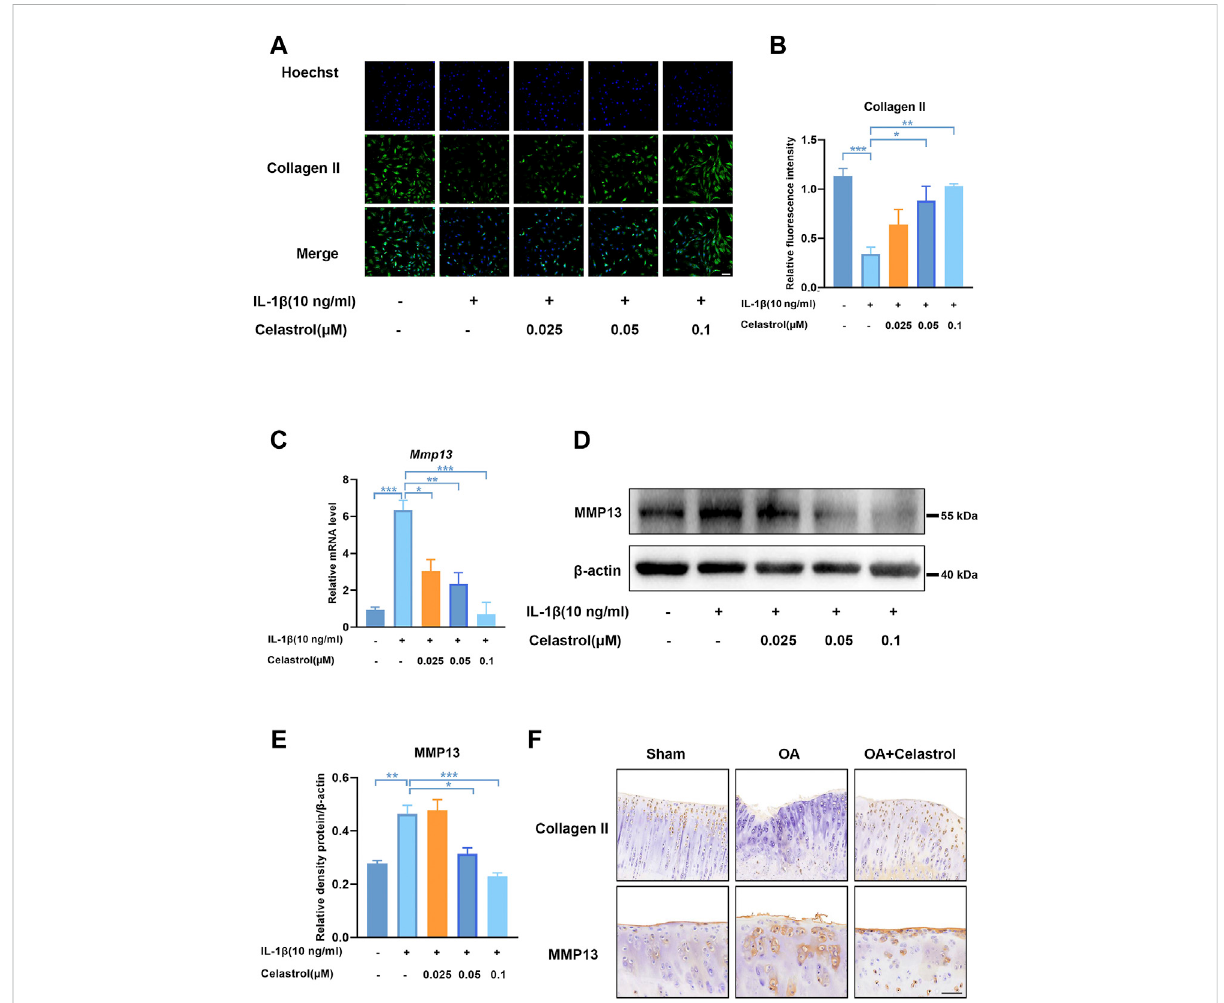
FIGURE 4 Celastrol inhibitedmatrix degradation inrat chondrocytes. (A) Representative immuno fl uorescence staining for Collagen Ⅱ inrat chondrocytes (green: Collagen Ⅱ , blue: DAPI, scale bar:100 μ m). (B) Quanti fi cation of the immunohistochemical staining data from A. (C) The mRNA levels of MMP13 in rCHs were assayed by real-time PCR. (D) Representative Western blot results for MMP13 in rCHs treated as indicated. (E) Quanti fi cation of Western blot data from D. (F) Immunohistochemical staining for Collagen Ⅱ and MMP13 in the affected joint cartilage of rats from different groups (scale bar:50 μ m). All data represent mean ± S.E.M.* p < 0.05, ** p < 0.01 and *** p < 0.001. All experiments were repeated 3